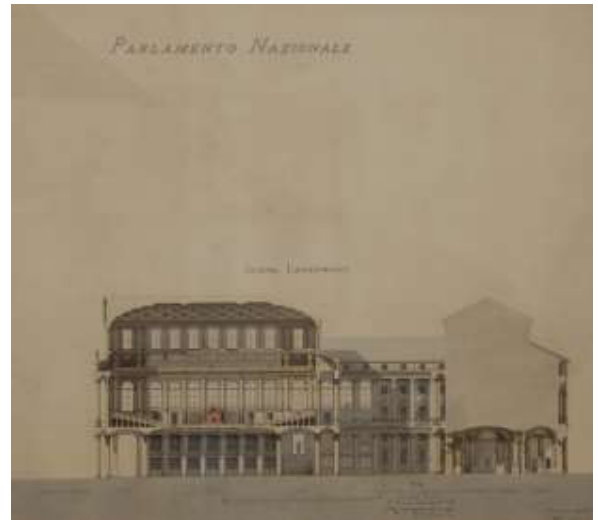
Figure 1. Alessandro Antonelli, National Parliament,